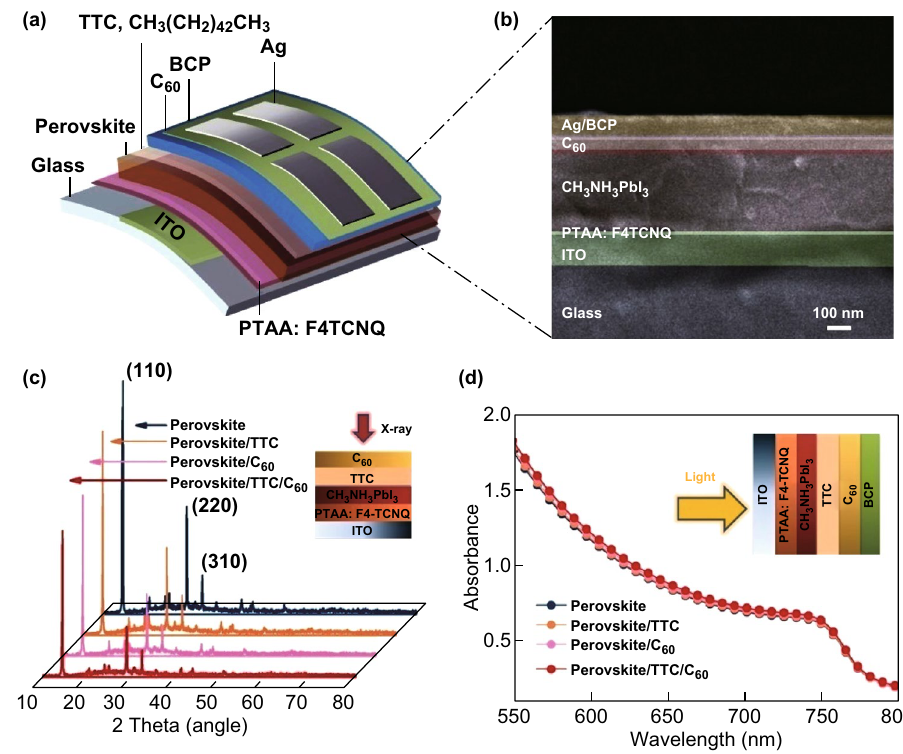
Fig. 1 a Device structure used in this study. b Cross-sectional SEM image of the full device, including a TTC interlayer (scale bar: 100 nm). c XRD spectra of the pristine and perovskite films with TTC, C 60 , and TTC/C 60 layer. d UV–Vis spectra of the perovskite films with different pas- sivation